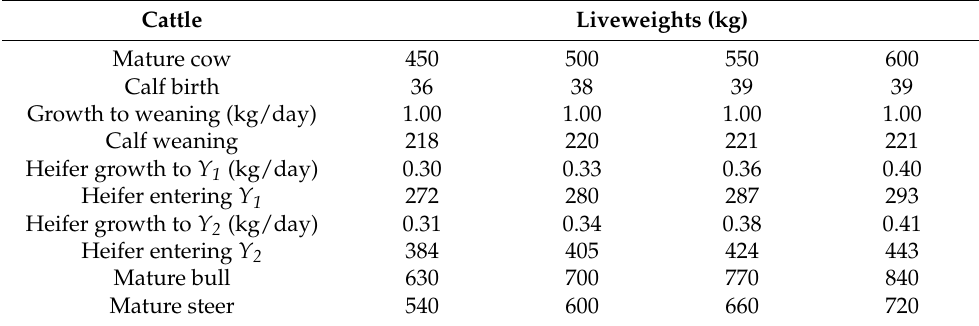
Table 3. Liveweights for cattle for scenario C with varying mature cow liveweight. Calf birth weights were decreasing ratios of mature cow liveweight as cow liveweight increased and all calves were assumed to grow at 1.00 kg/day until weaning. Heifers were 12 months of age when entering Y 1 and 24 months of age when entering Y 2